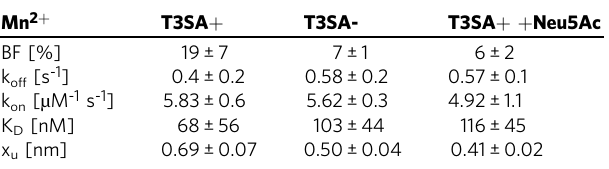
Table 2 Comparison of kinetic and thermodynamic parameters describing sialic acid dependence of reovirus virion interaction with β 1 integrin.